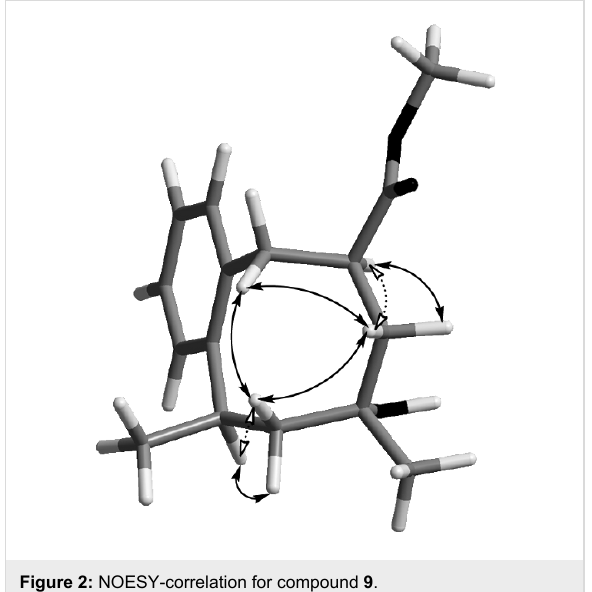
Figure 2: NOESY-correlation for compound 9 .